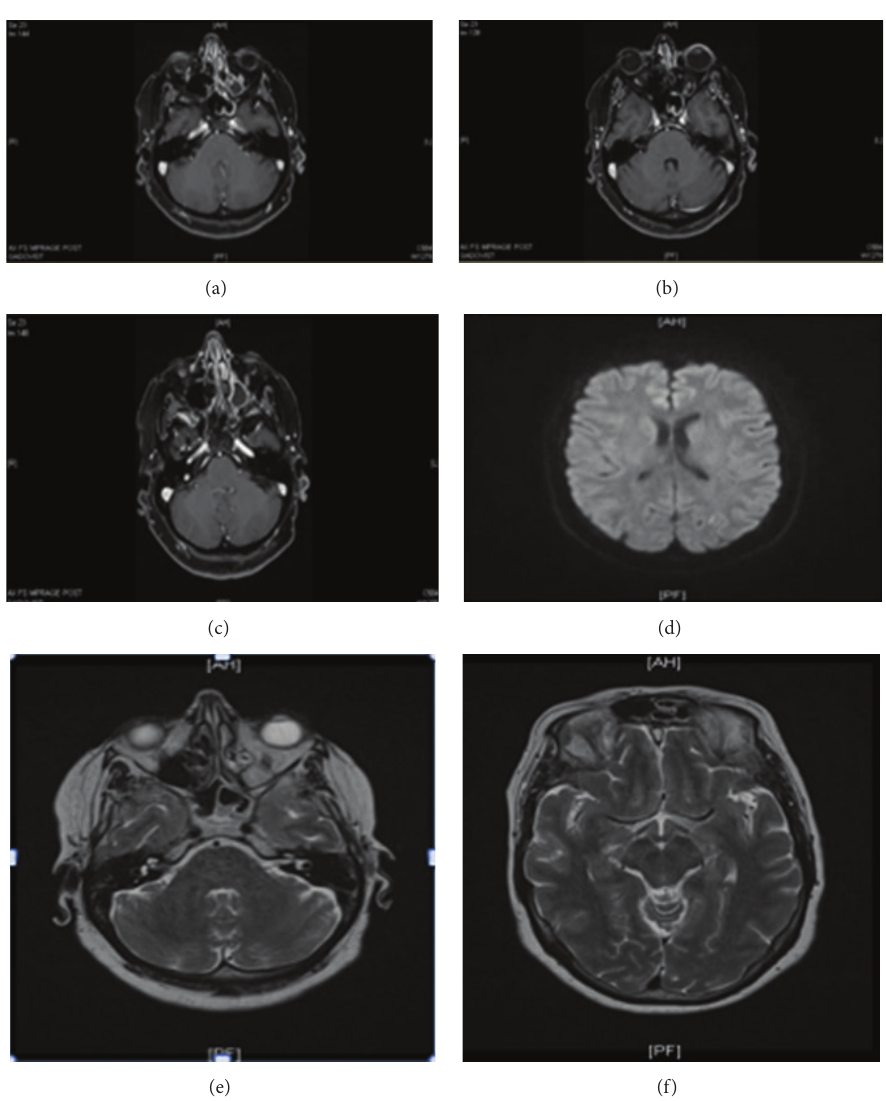
Figure 1: Brain magnetic resonance imaging (MRI) with contrast 6 weeks later. (a, b) T1 (magnetization-prepared rapid acquisition with gradient echo): tiny focus of enhancement seen within the superior portions of the right internal auditory canal. (c) T1 (magnetization- prepared rapid acquisition with gradient echo): tiny focus of enhancement seen at the posterior portions of the basal turn of the cochlea. (d) Diffusion Weighted Image: left superior occipital white matter with restricted diffusion. (e) T2-weighted sequence: no enhancement at